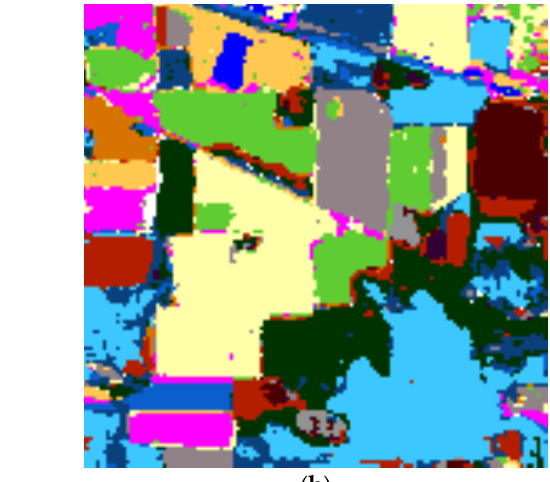
Figure 6. Spatial information-dominated classification result for Pavia University ( a ) and Indian